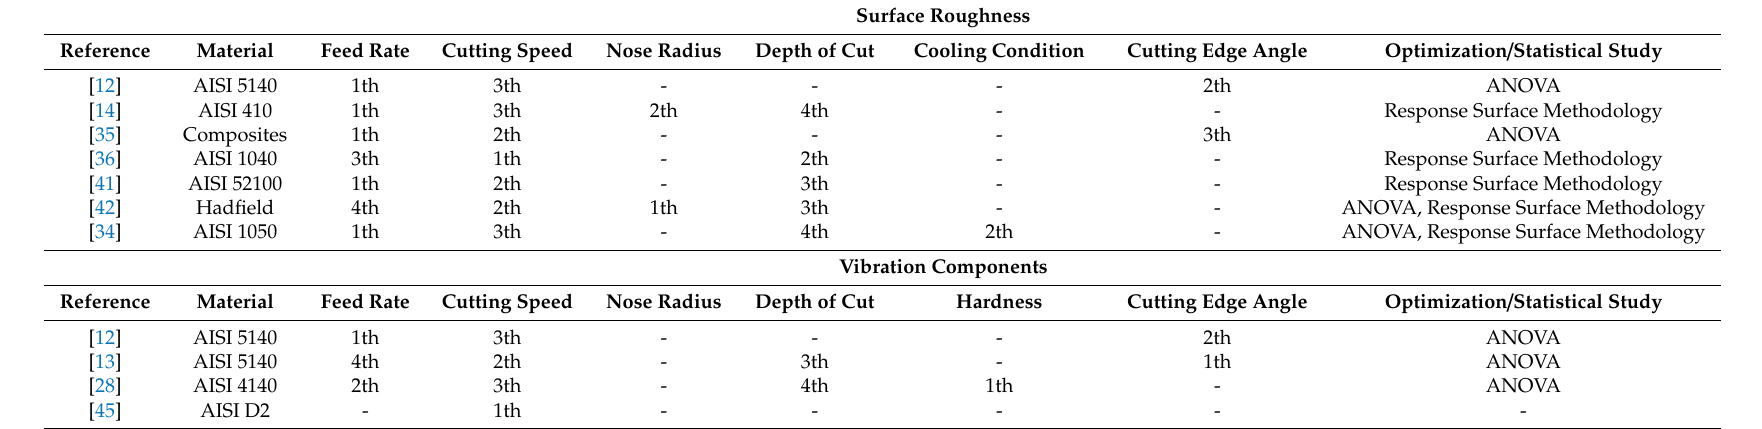
Table 1. The most influential parameters in di ff erent studies on turning steel